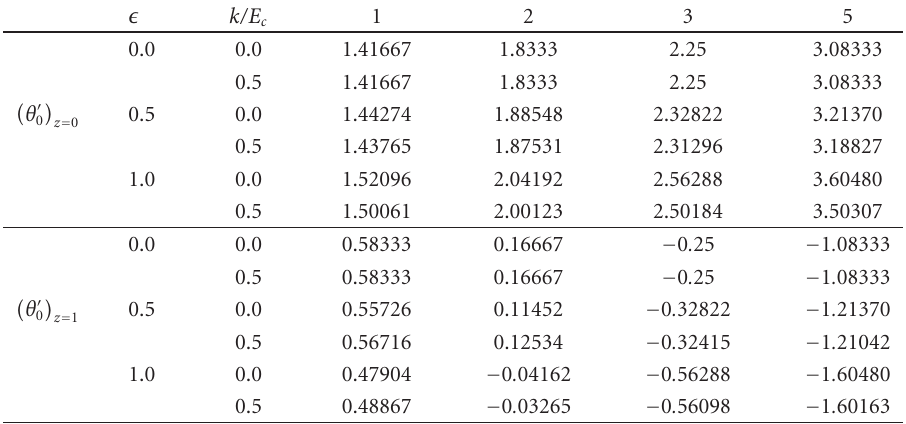
Table 6.2. Steady heat transfer coe ffi cient ( θ (cid:5) 0 ) z = 0 and ( θ (cid:5) 0 ) z = 1 for σ = 10, λ 1 = 0 . 1, P r = 10.